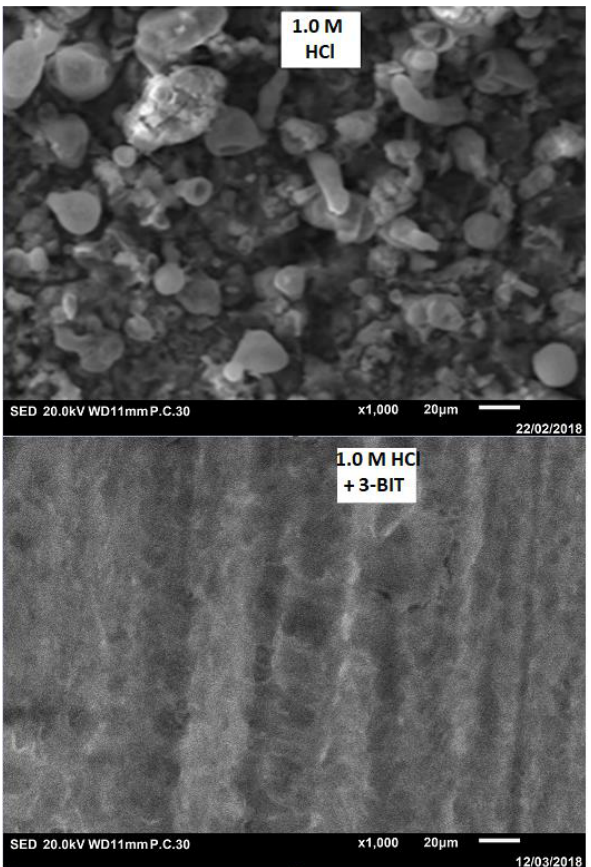
Figure 5. Surface morphology by SEM for MS immersed in 1.0 M HCl in the absence and presence of 3-BIT.